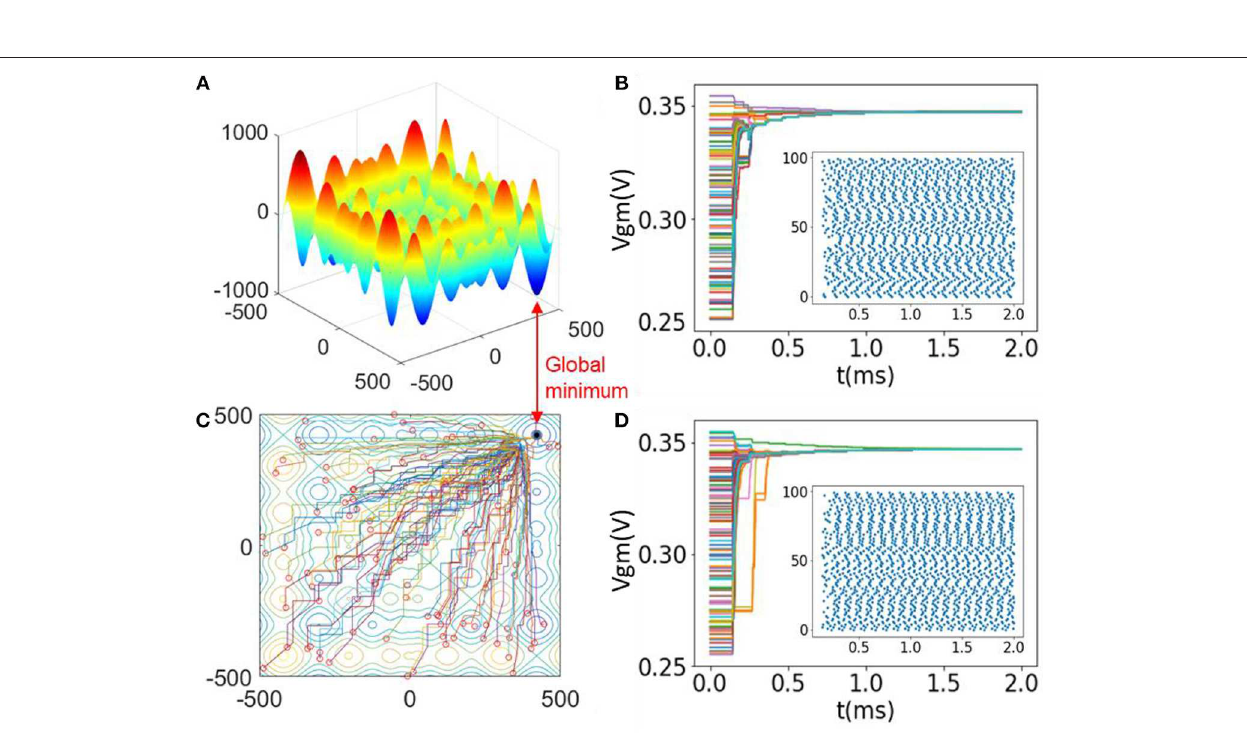
FIGURE 6 | (A) Landscape of 2-D Schwefel’s function; (B) Contour map with solution traces of each agent in the optimization process of (A) ; (C,D) Evolution of V GM in two searching networks with raster plots.